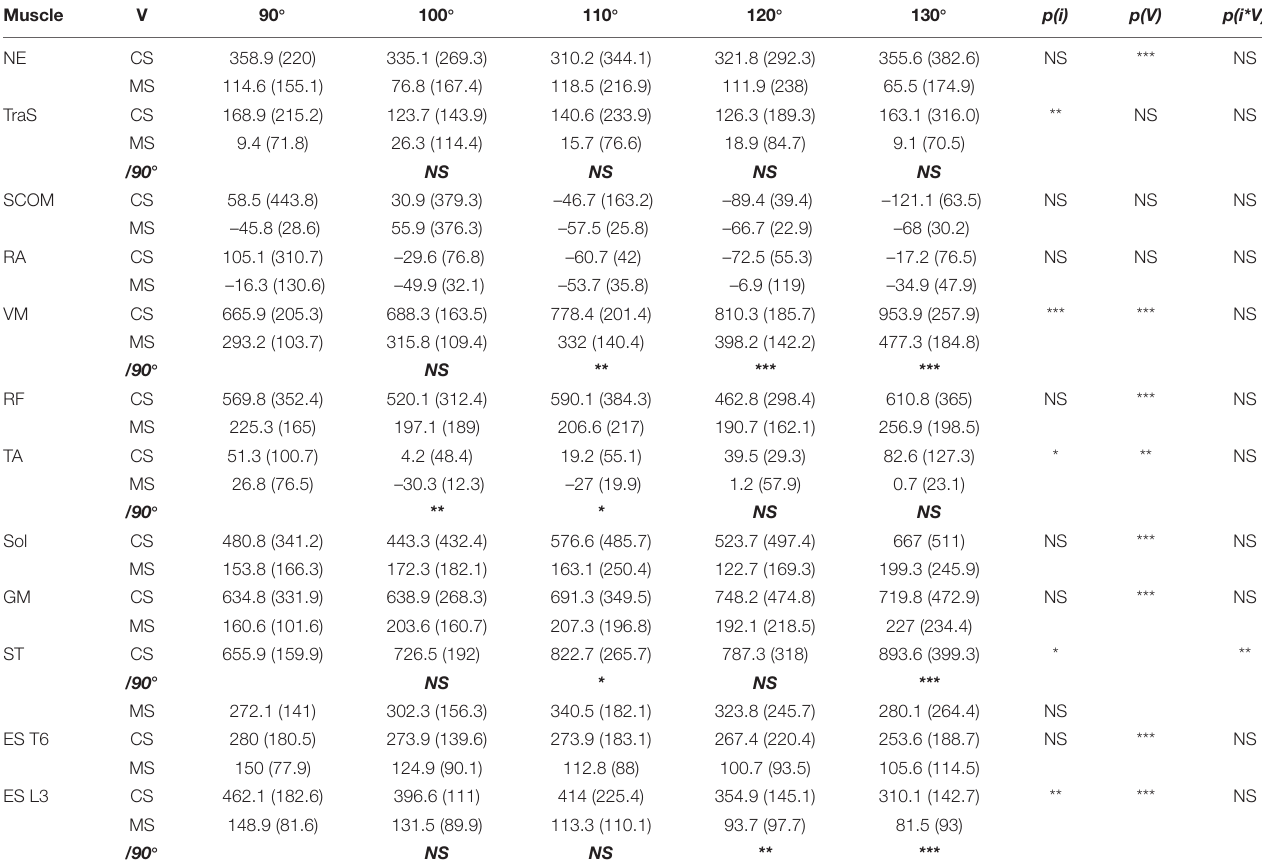
TABLE 1 | Mean (SD) muscle onset times, in ms, for the 5 inclination conditions and for the 2 execution speeds, and p -values for effects of inclination (i), speed (V), and their interaction (i*V). Muscle